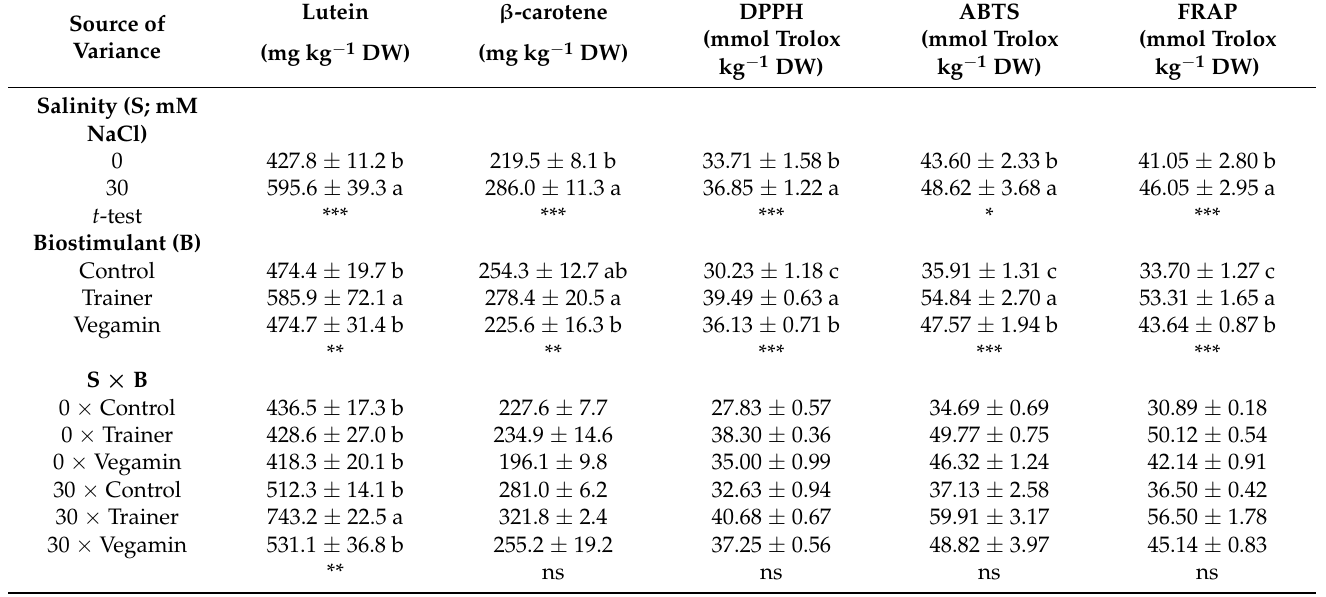
Table 4. Auxiliary pigment content and antioxidant activity of lettuce leaves as affected by salinity and biostimulant